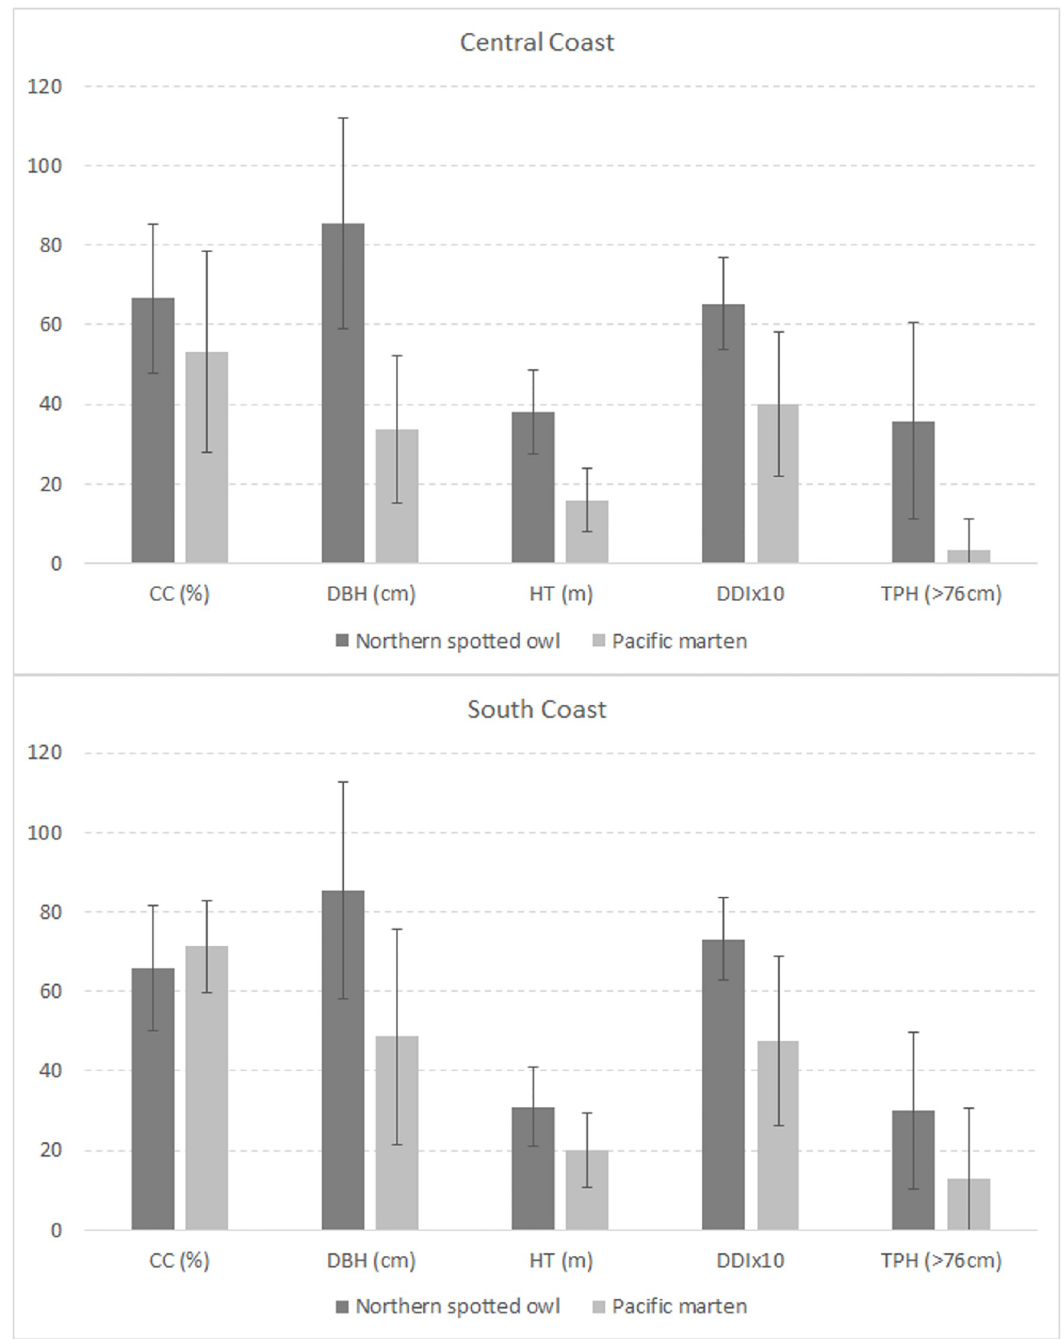
Fig 7. Humboldt marten and spotted owl distribution prediction averages. Mean ( ± 1SD) for each covariate used in predicted use areas for northern spotted owls ( Strix occidentalis caurina ) and a coastal subspecies of Pacific martens ( Martes caurina humboldtensis ). Variables were selected from remotely sensed data [7] and included canopy cover (CC), diameter at breast height (DBH), tree height (HT), Diameter Diversity Index (DDI) and Trees Per Hectare (TPH) with descriptions of variables located in